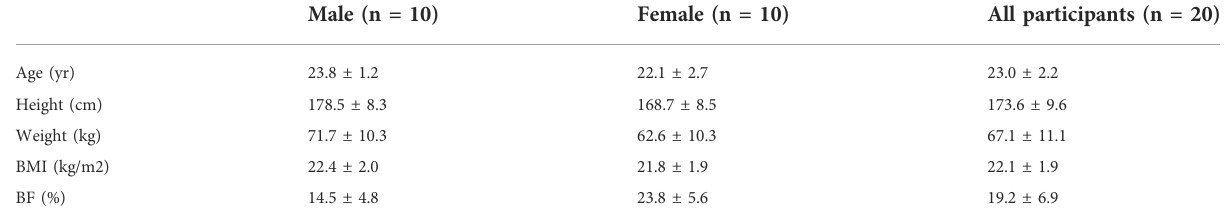
TABLE 1 Physical characteristics of participants.